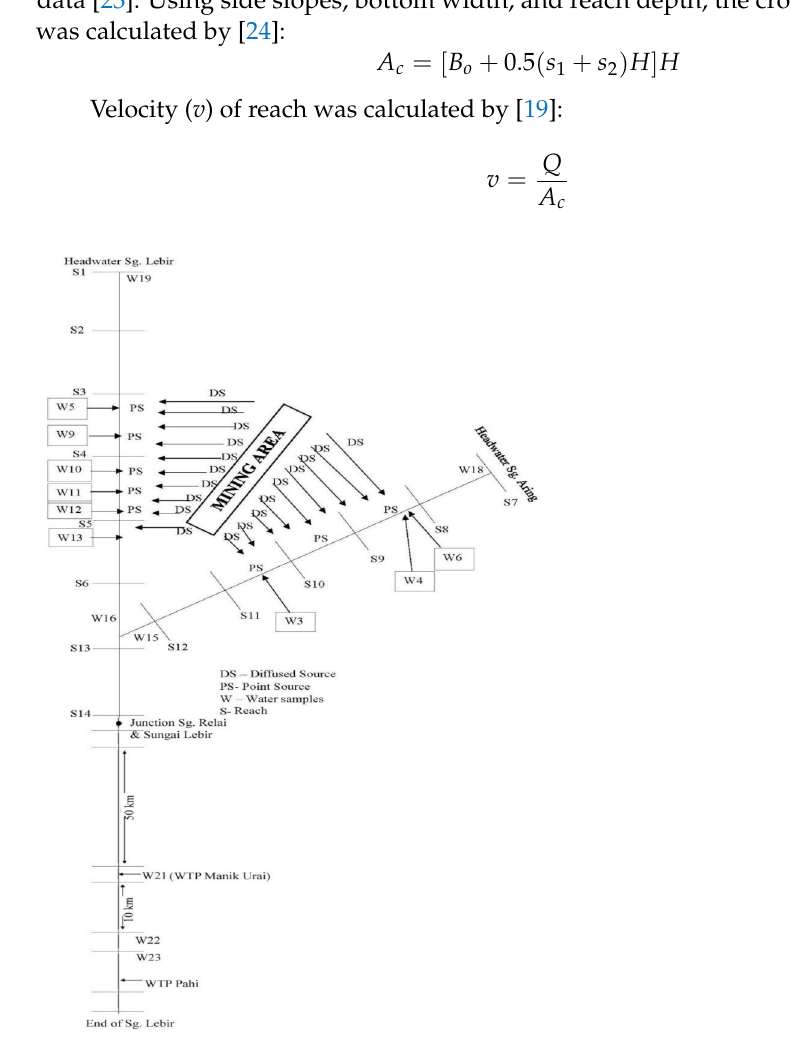
Figure 2. Schematic diagram of Qual2k modeling. Location of reaches, water samples, water treatment plants, diffused source, and non-diffused source is shown